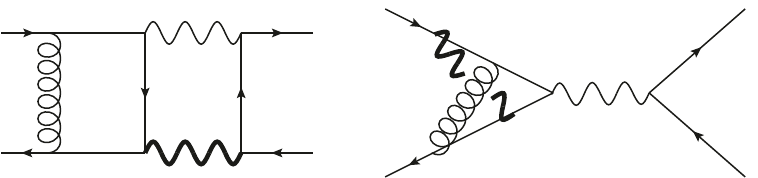
Figure 1. Selected planar and non-planar two-loop Feynman diagrams for Drell-Yan lepton pro- duction. The heavy wavy lines denote a Z boson, the light wavy lines denote a photon, and the curly lines denote a gluon.